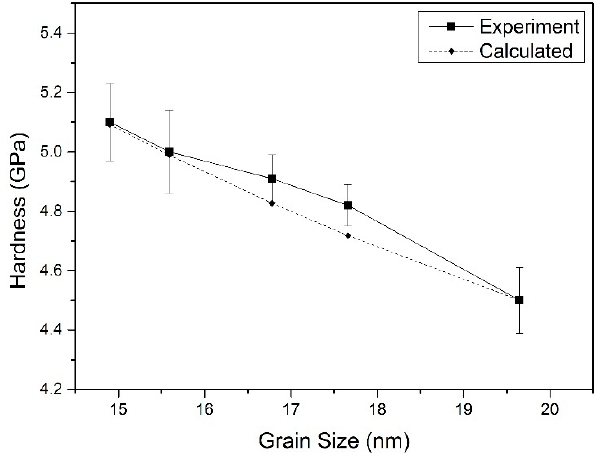
Figure 4. Tendency of the hardness of Er films with grain Figure 4. tendency of the hardness of Er films with grain sizes.